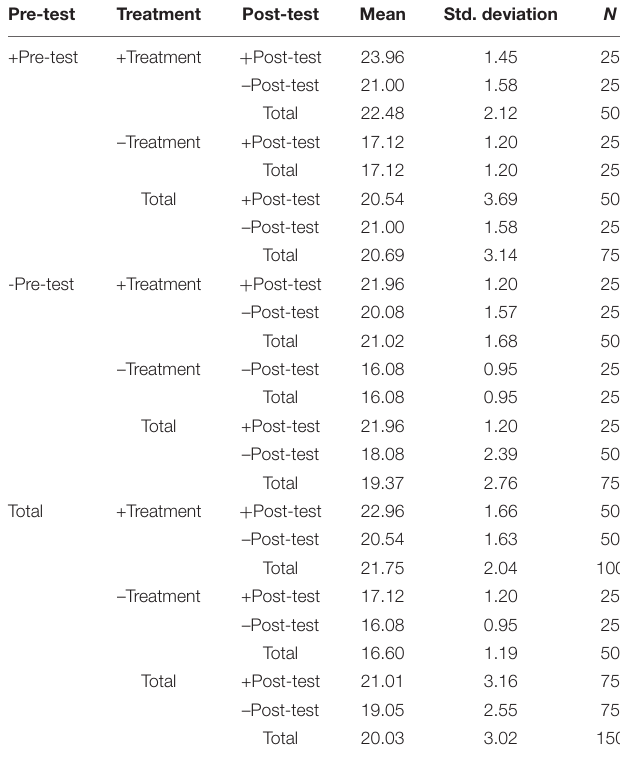
TABLE 6 | Descriptive statistics for comparing the effects of ± treatment, ± pre-test, and ±